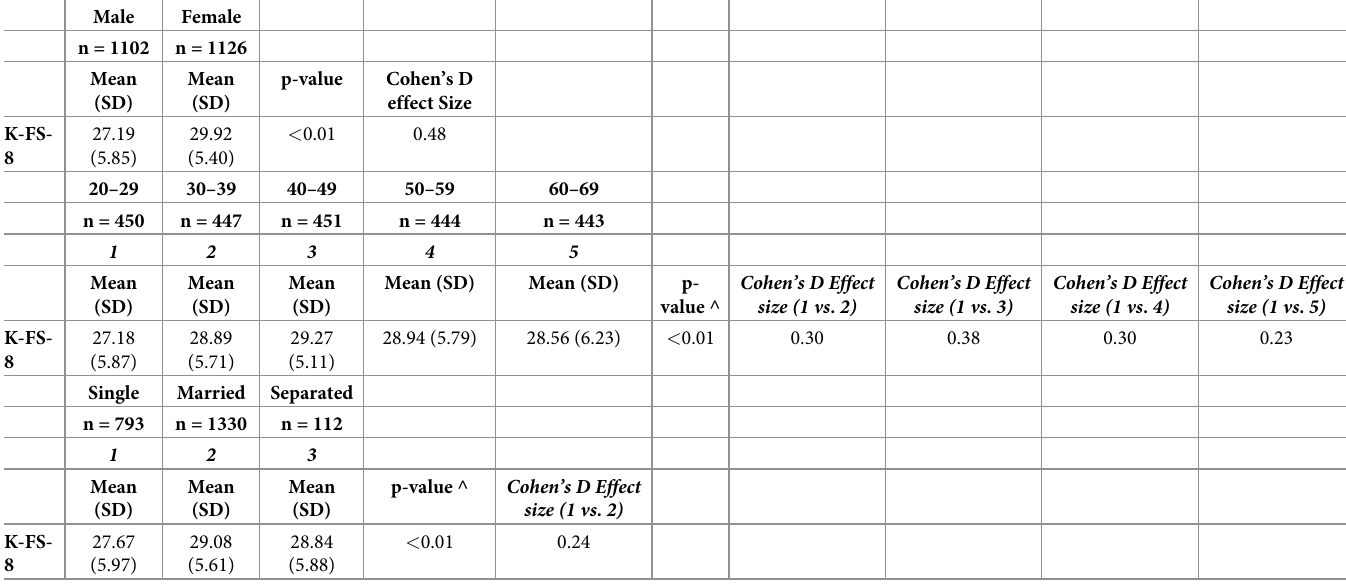
firmed (Fig 1). 3.4.2. Model fit. The SRMSR value = 0.072 indicates that the data fit the model satisfacto- rily using the suggested cut-off values of SRMSR � 0.08 as criteria for assessing fit. The CFI = 0.928 barely fell short of the recommended 0.95 threshold. 3.4.3. IRT item fit and IRT parameters. All RMSEA values were below 0.06, suggesting that the items fit the model well. Table 5 displays the estimated IRT parameters. The slope